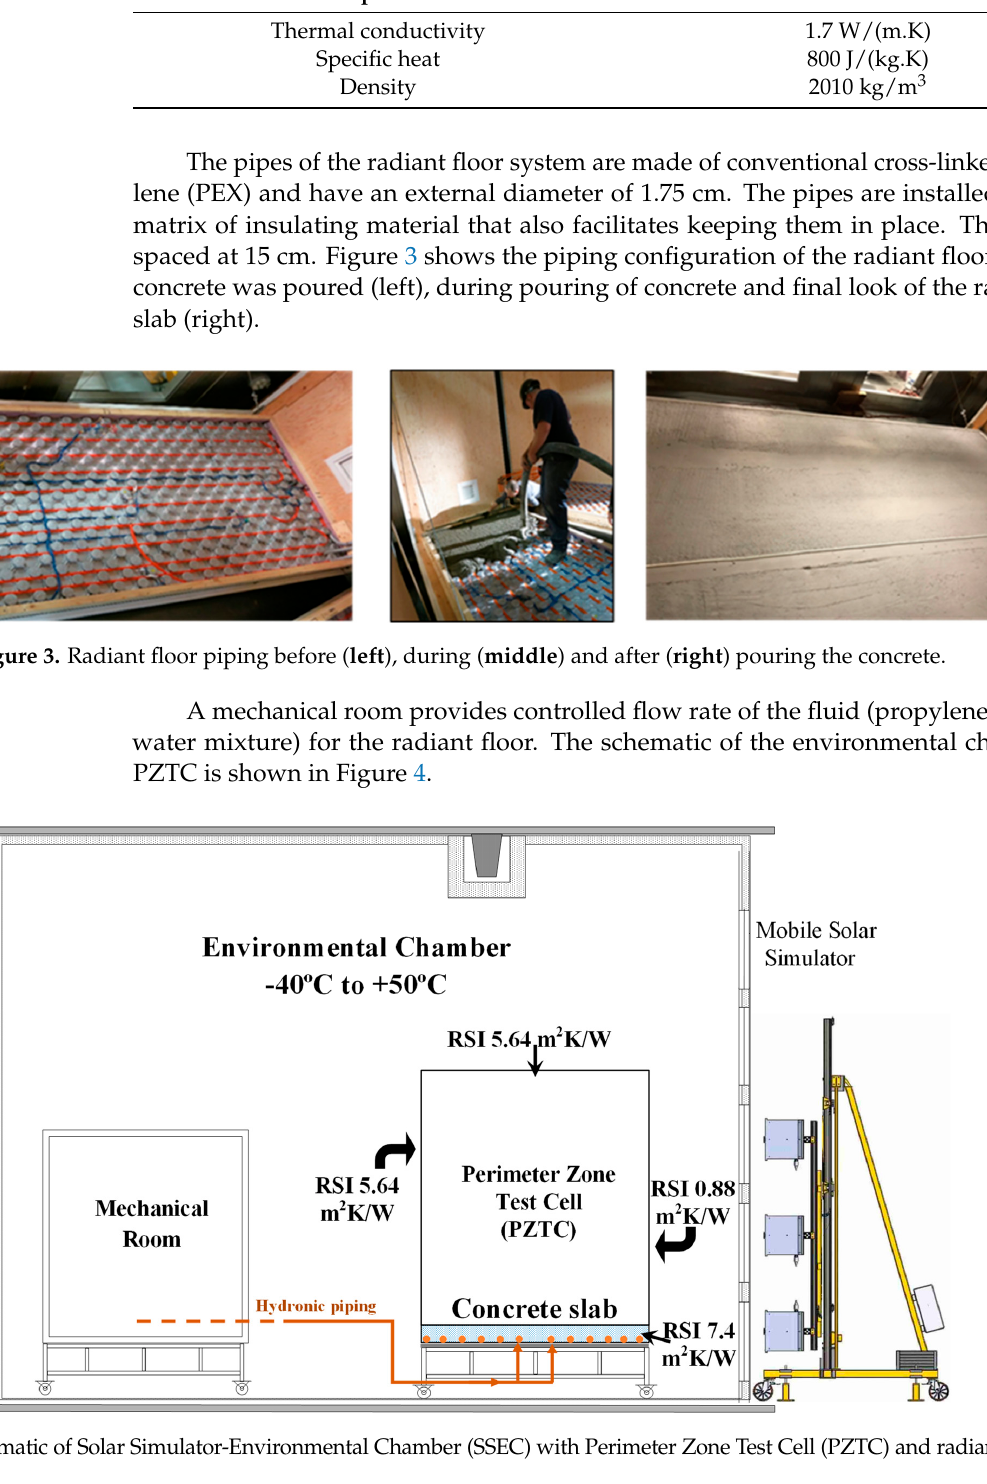
Table 1. Thermal properties of concrete.